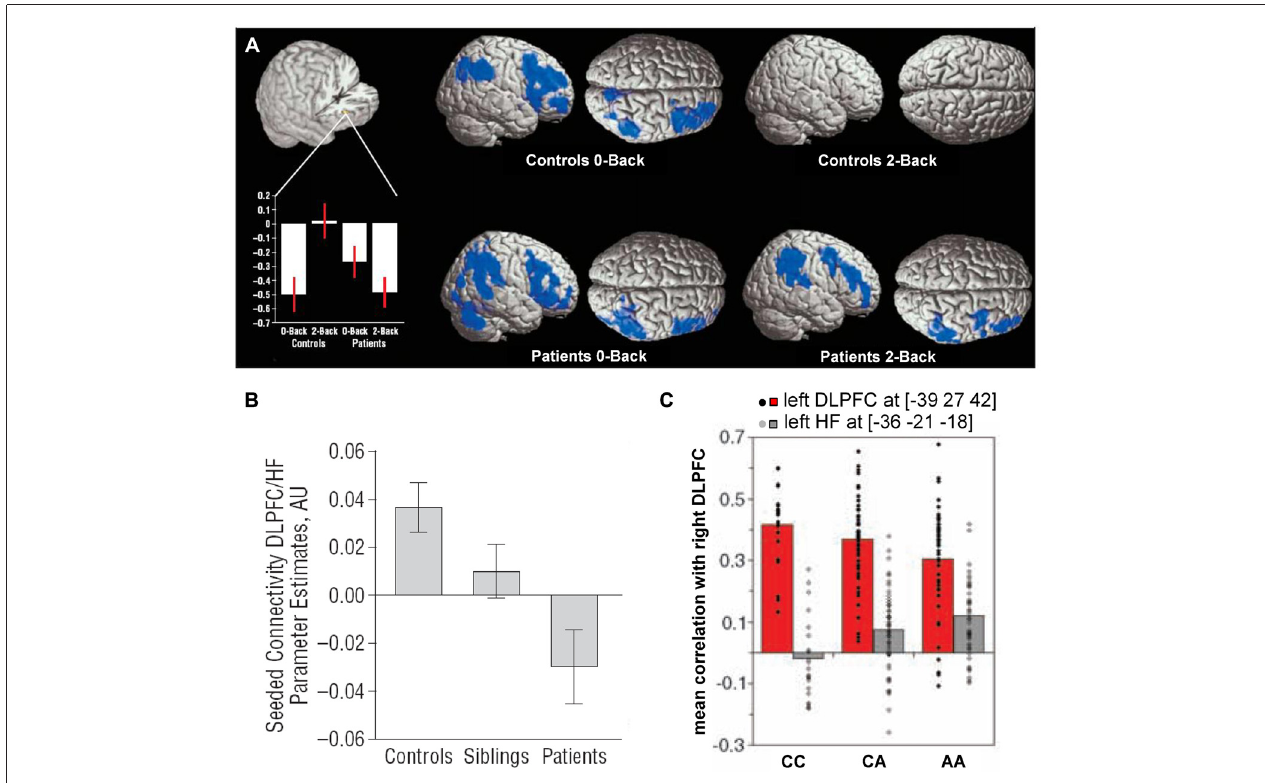
FIGURE 3 | Hippocampal-prefrontal interactions in schizophrenia patients and at-risk individuals. (A) Hippocampal-prefrontal functional connectivity during working memory in schizophrenia. Bottom left: connectivity of the dorsolateral PFC with the hippocampus (cutout above) during performance of an n-back task. During a control condition (0-back), connectivity was negative in controls and patients. However, during the working memory condition (2-back) connectivity was absent in controls but persisted in patients. Voxels highlighted in blue indicate regions showing negative functional connectivity with the hippocampus. Adapted from Meyer-Lindenberg et al. (2005). (B) Connectivity between the hippocampus and PFC in schizophrenia patients, their unaffected siblings and control subjects. Note that the connectivity in siblings is intermediate between that of patients and controls. Adapted from Rasetti et al. (2011). (C) Hippocampal-prefrontal connectivity in carriers of a schizophrenia risk allele in the gene ZNF804A . Connectivity between the right dorsolateral PFC and left hippocampus (gray bars) increases with the number of risk allelels (A). Also shown is connectivity with the contralateral PFC (red bars). Adapted from Esslinger et al.